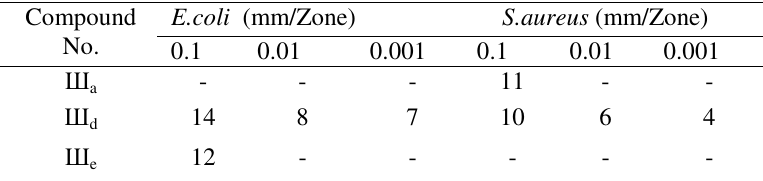
Biological Activity